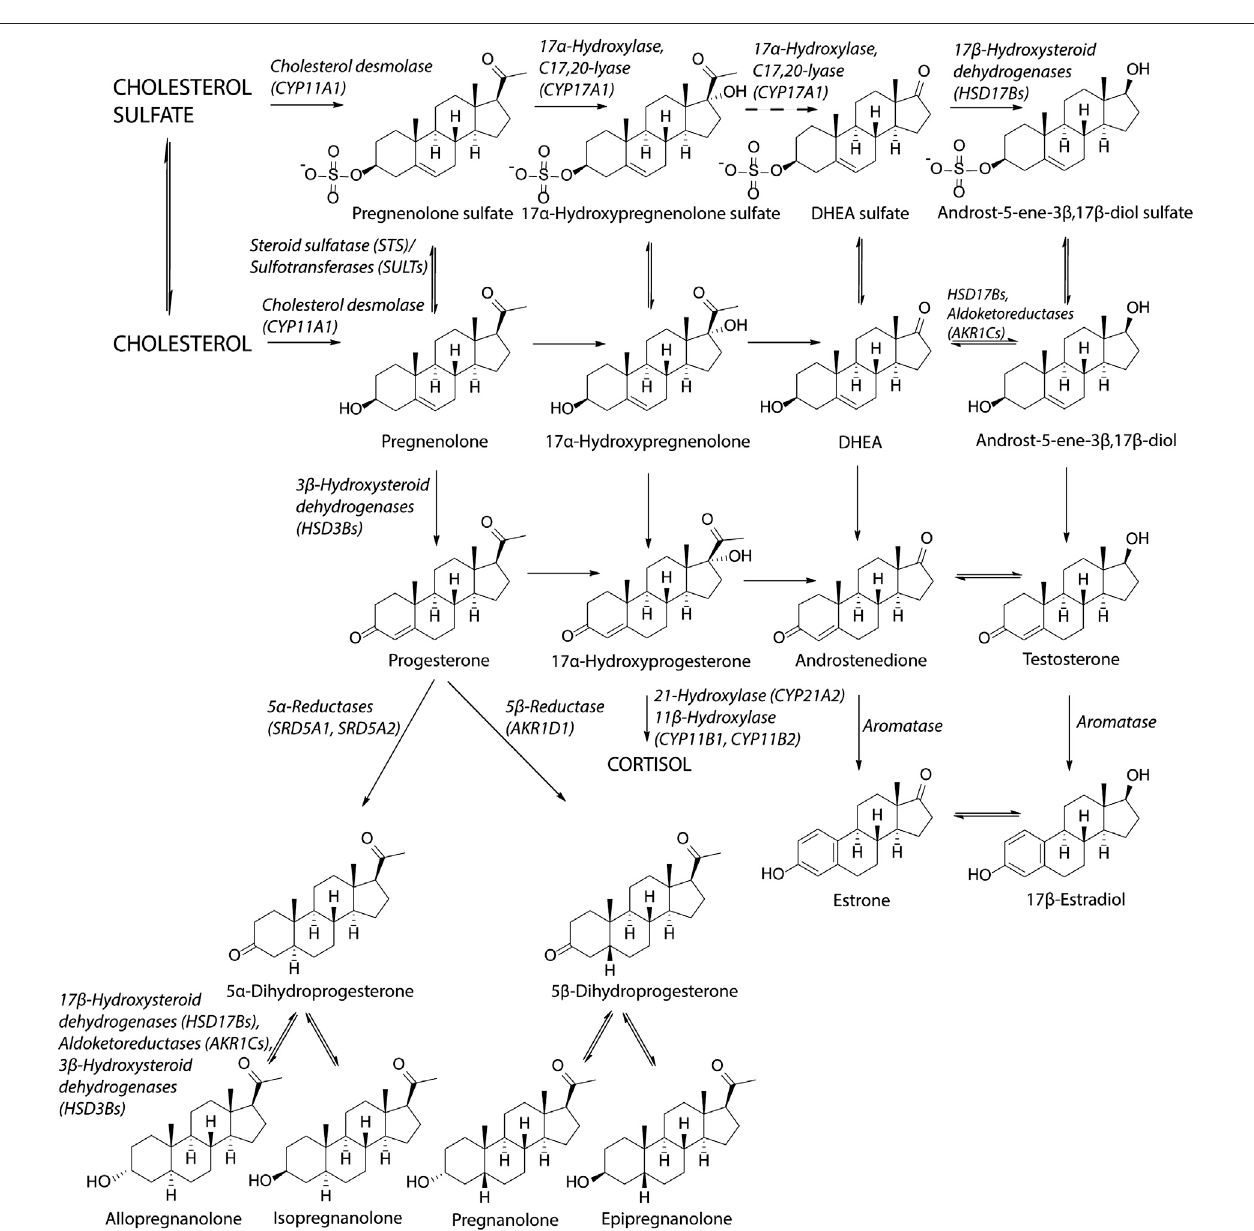
FIGURE 1 | Scheme of steroidogenesis. Steroidogenic pathway for sulfated steroids is similar as the biosynthesis of unconjugated steroids. Cholesterol can be sulfatedbysulfotransferase(SULT2B1b)tocholesterolsulfate(Fudaetal.,2002).Cholesterolsulfatecanbeconvertedtopregnenolonesulfatebycholesteroldesmolase while cholesterol sulfate serves as a better substrate than unconjugated cholesterol (Tuckey, 1990). Pregnenolone sulfate can be subsequently converted to 17 α - hydroxypregnenolonesulfatebyCYP17A1inthesamewayaspregnenolone(Neunzigetal.,2014).ThelyasereactionofCYP17A1hasnotbeencon fi rmedtotake placebyrecentstudies(Neunzigetal.,2014;Sánchez-Guijoetal.,2016;NeunzigandBernhardt,2018),althoughearlierstudiesindicatedthisconversion(Lamontetal., 1970; Jaffe et al., 1972). DHEAS can be converted to androst-5-ene-3 β ,17 β -diol sulfate by 17 β -hydroxysteroid dehydrogenases (Sánchez-Guijo et al., 2016; Qaiser et al., 2017). Regarding the unconjugated steroids, the reactions between DHEA and androst-5-ene-3 β ,17 β -diol, androstenedione and testosterone and estrone and estradiol are preferentially conducted in the reductase direction (Purohit and Foster, 2012; Mostaghel, 2013).